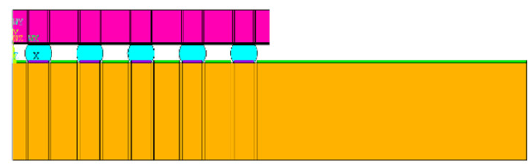
Figure 2. WLP-2 semi-diagonal FEA model.